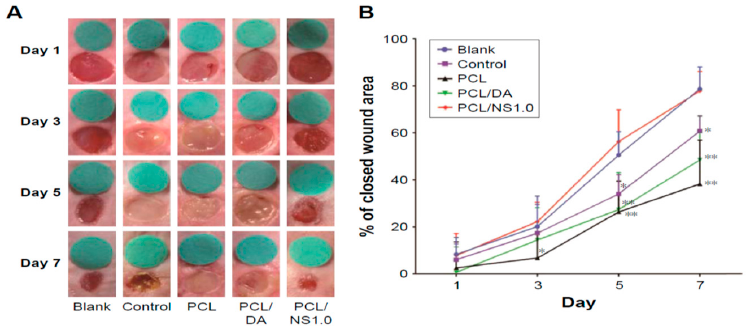
Figure 26. ( A ) Representative macroscopic images of mice wounds from the blank, control, PCL, PCL / DA and PCL / NS1.0 groups. ( B ) In vivo quantitative wound closure in mice at di ff erent time points. Data are presented as mean ± SD ( n = 5). Significant di ff erences exist between PCL / NS1.0 and the control, as well as PCL and PCL / DA groups, * p < 0.05, ** p <